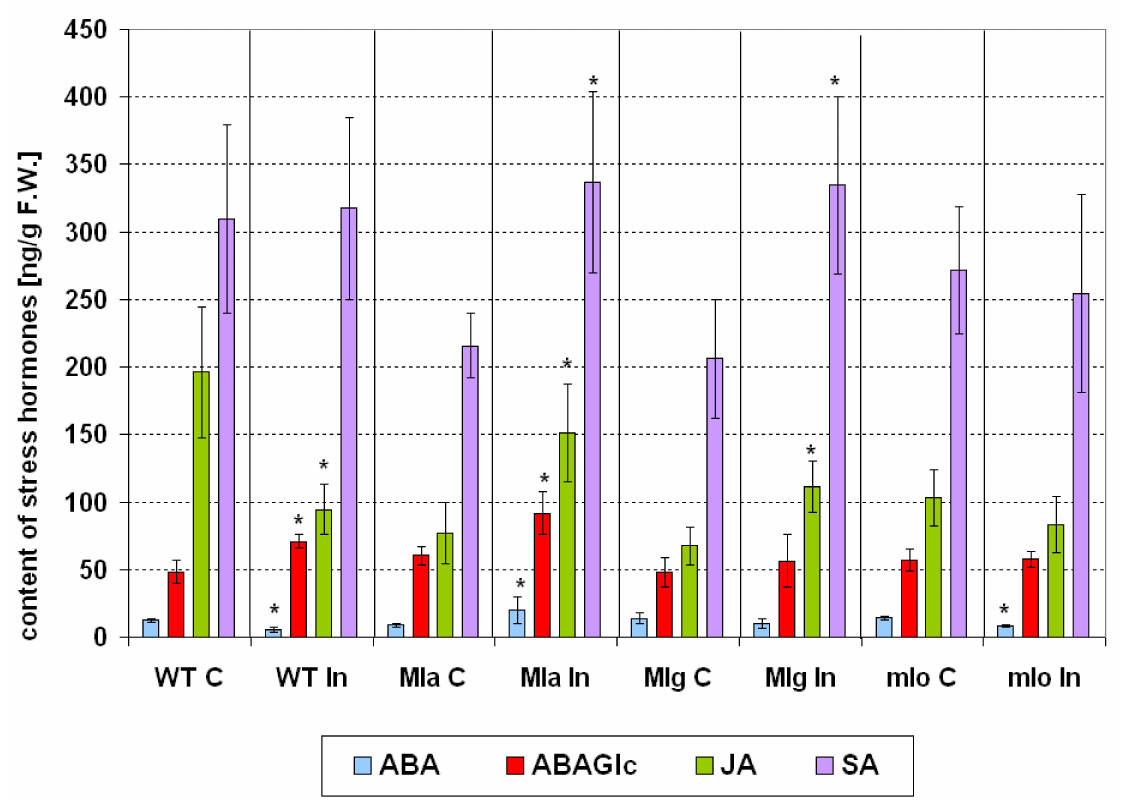
Figure 8. Changes in the contents of four stress hormones in leaves of the susceptible barley cultivar Ingrid and its three near-isogenic lines Mla, Mlg, and mlo at seven days following powdery mildew inoculation (7 dpi). Abbreviations: C, control; In, powdery mildew inoculated; WT, wild type cultivar Ingrid. Investigated hormones: ( ± )- cis, trans -abscisic acid (ABA, active form), ( ± )- cis, trans -abscisic acid glucosyl ester (ABAGlc, inactive form), ( ± )-jasmonic acid (JA, active form), and salicylic acid (SA, active form). Means of five independent repetitions ± SD are shown. The symbol * shows significant di ff erences between inoculated and control leaves ( p < 5%, Student t test) for each genotype (and for particular hormone)